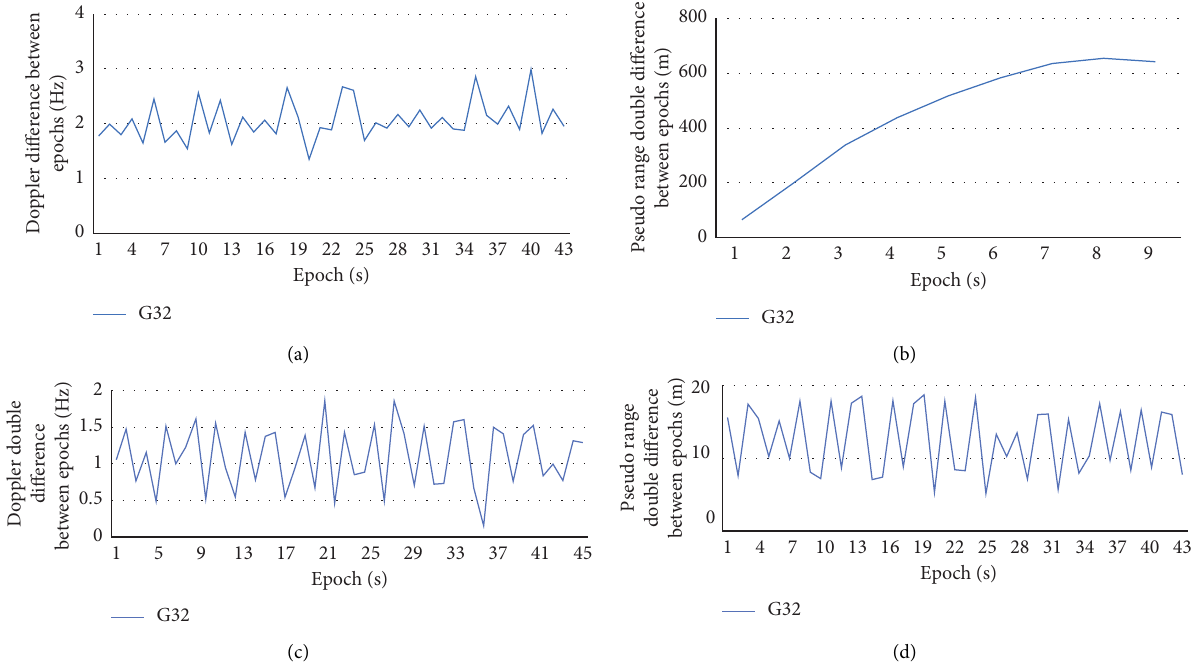
Figure 5: Doppler diference and pseudorange diference between ephemeris elements of the G32 satellite. (a) Doppler single diference. (b) Pseudorange single diference. (c) Doppler double diference. (d) Pseudorange double